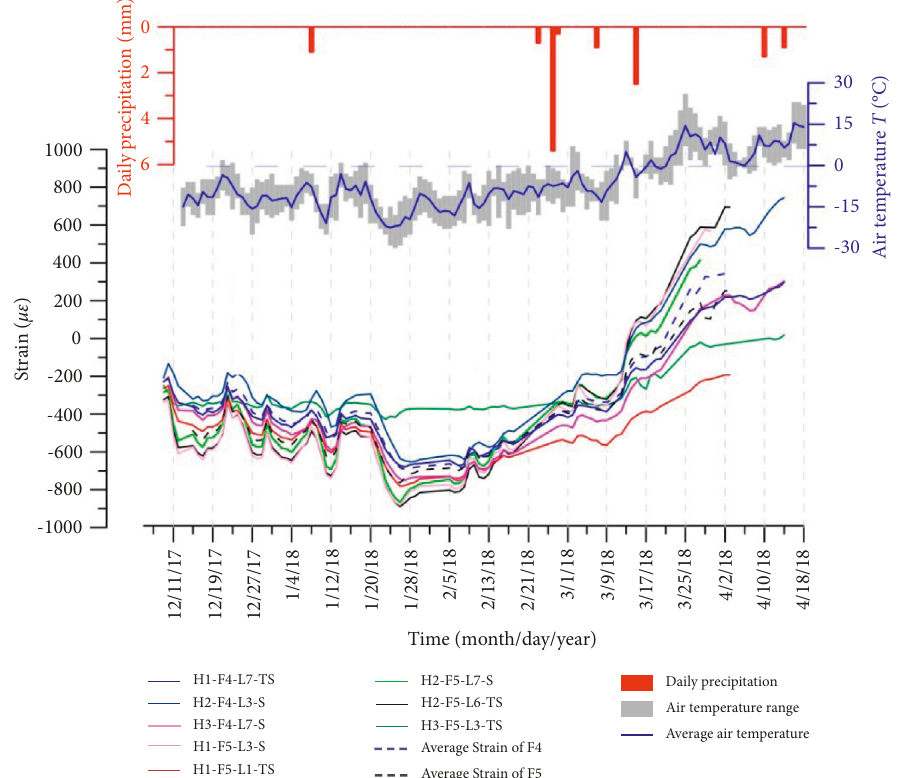
Figure 12: Curves of monitoring strain variation and calculated average strain in the F4 and F5 layers of the roadbed under climatic conditions.